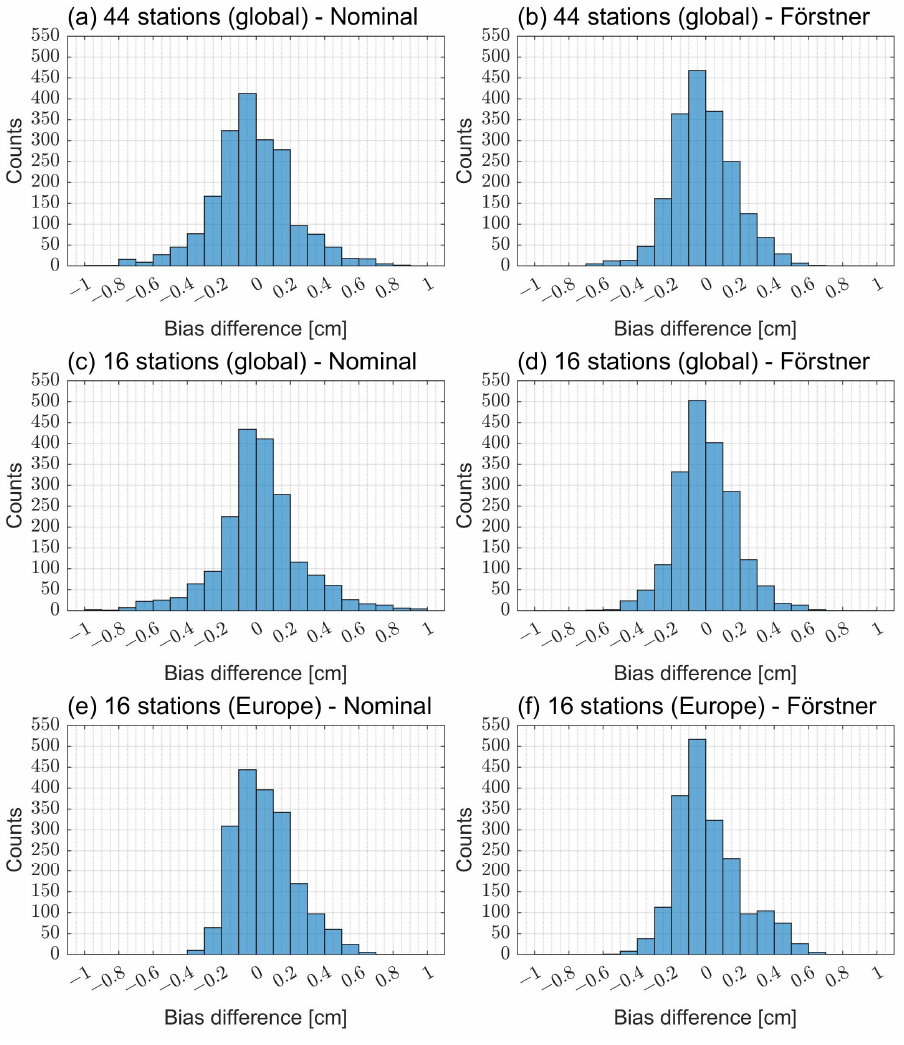
Figure 7. Histograms of ISL range bias differences for ( a ) 44 stations (global) with Nominal weighting, ( b ) 44 stations (global) with Förstner weighting, ( c ) 16 stations (global) with Nominal weighting, ( d ) 16 stations (global) with Förstner weighting, ( e ) 16 stations (Europe) with Nominal weighting, and ( f ) 16 stations (Europe) with Förstner weighting. Differences were computed for simulation scenarios for ISL range biases equal to 0.5 cm and 1.0